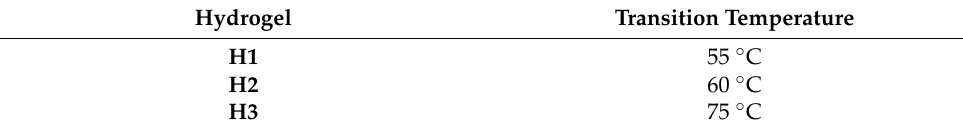
Figure 7. The gel – sol – gel transition recycle of H1 . Figure 7. The gel–sol–gel transition recycle of H1 . Table 2. The transition temperature of H1 , H2 , and H3 with 90% water content. Hydrogel Transition Temperature